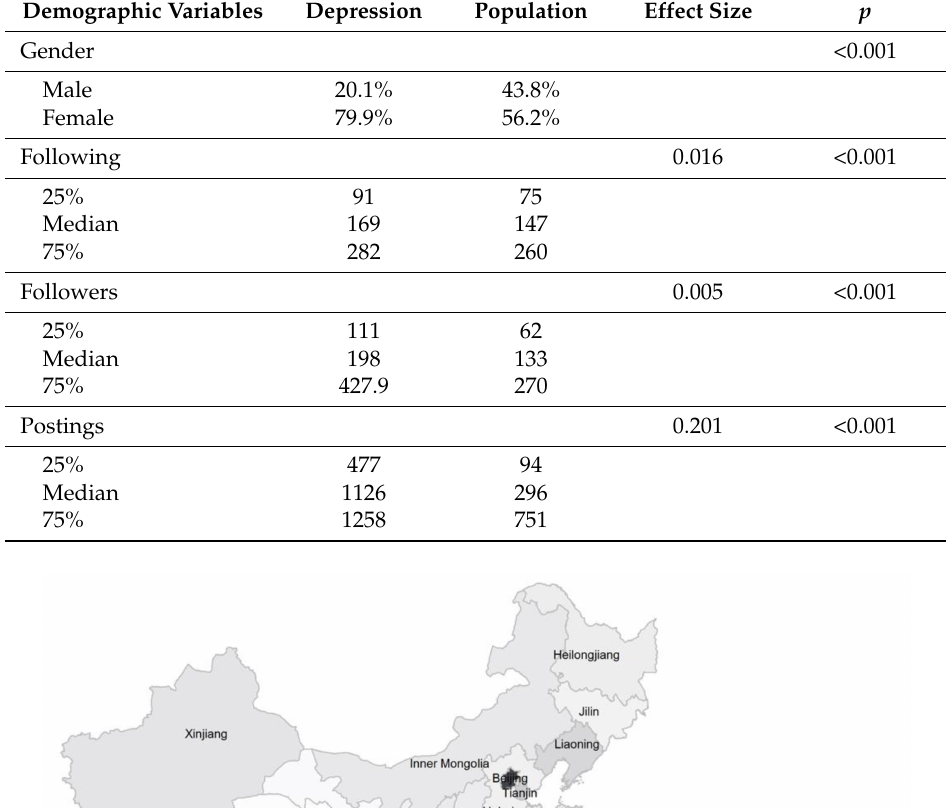
Table 2. Demographic characteristics of Sina Weibo users.